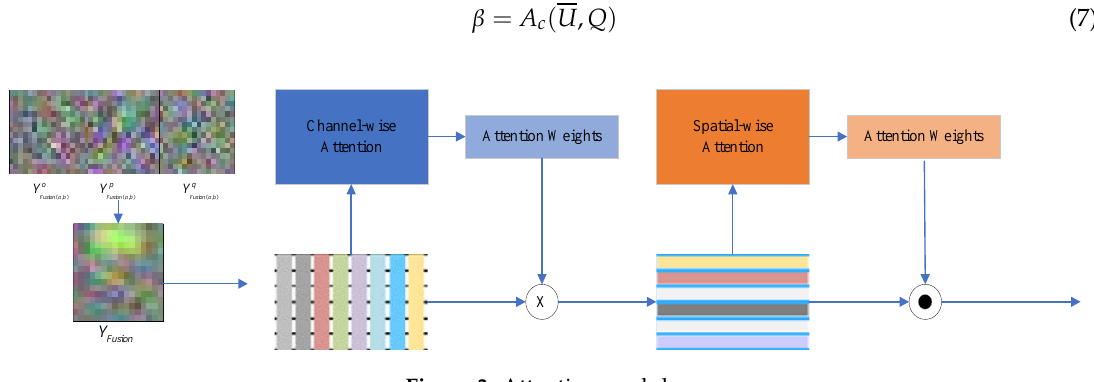
Figure 3. Attention module.